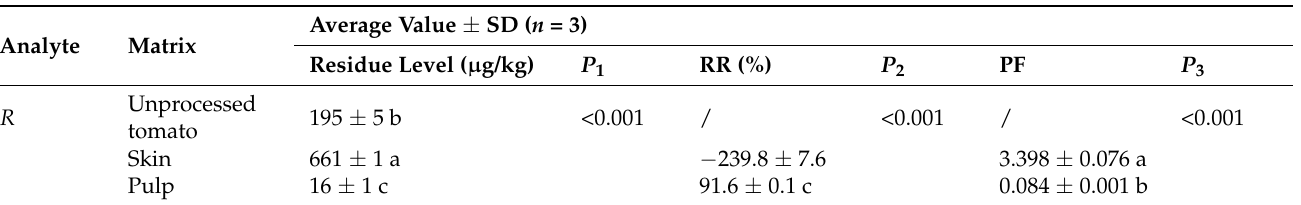
Table 5. Residue level, RR, and PF values of enantiomeric and racemic mandipropamid in unpro- cessed and different parts of tomato and cucumber samples.